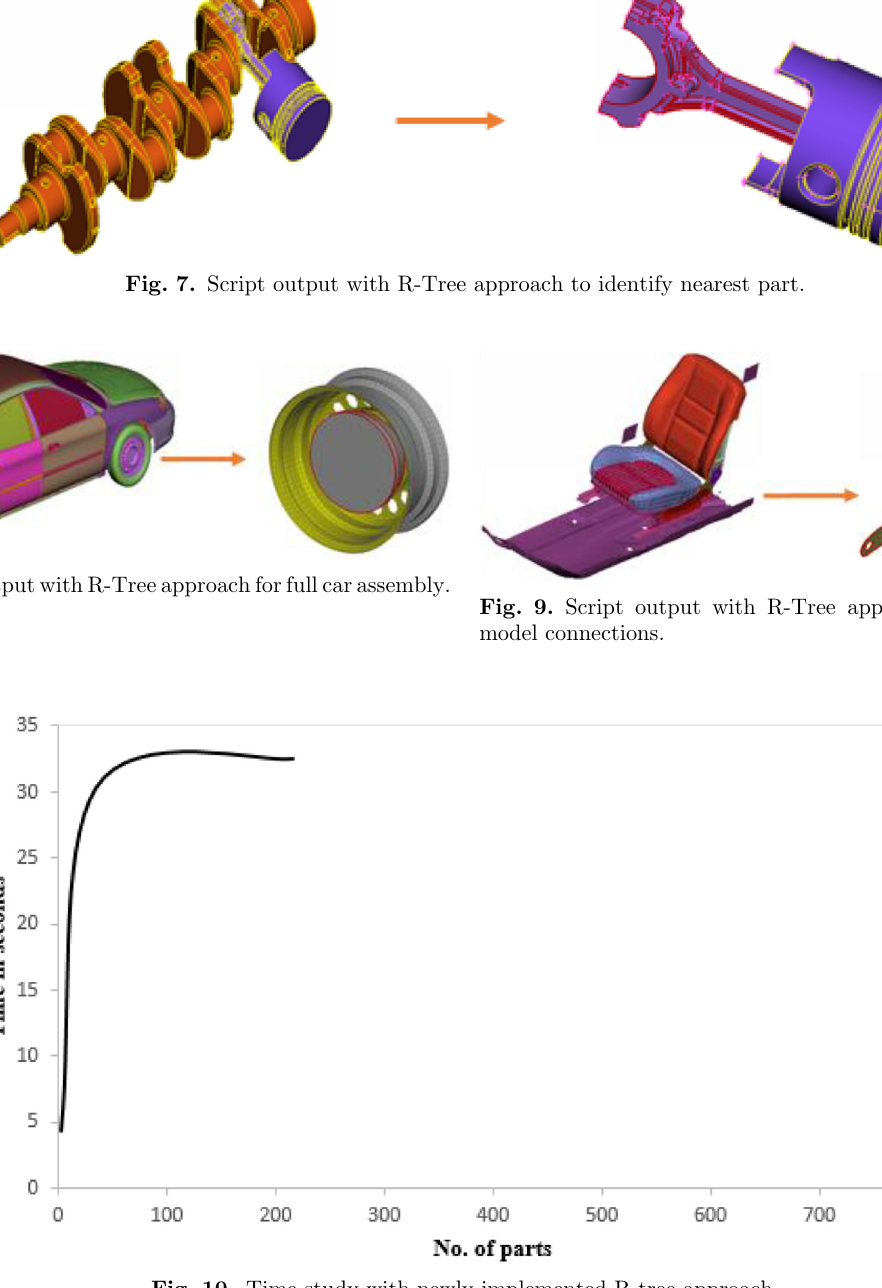
Fig. 10. Time-study with newly implemented R-tree